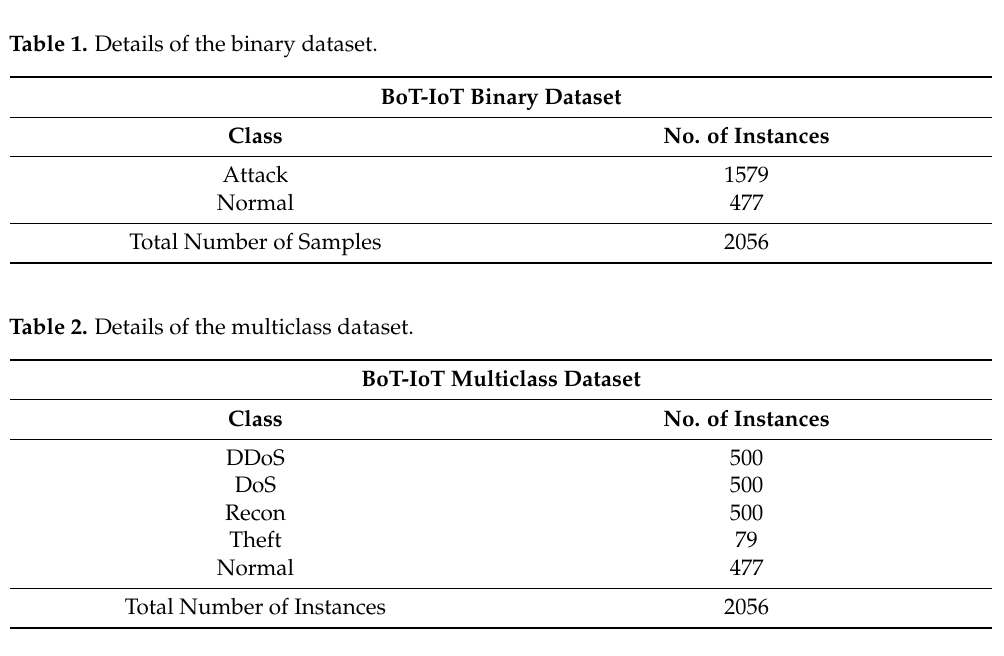
Table 1. Details of the binary dataset.